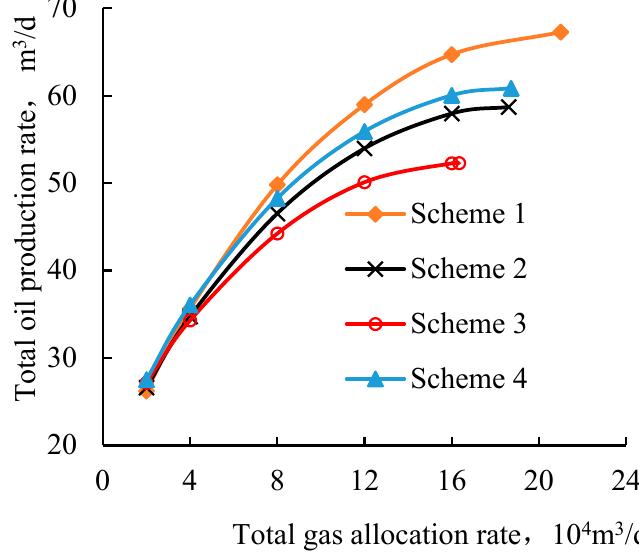
Figure 3. Block GLPCs of various schemes with the maximum oil production rate.